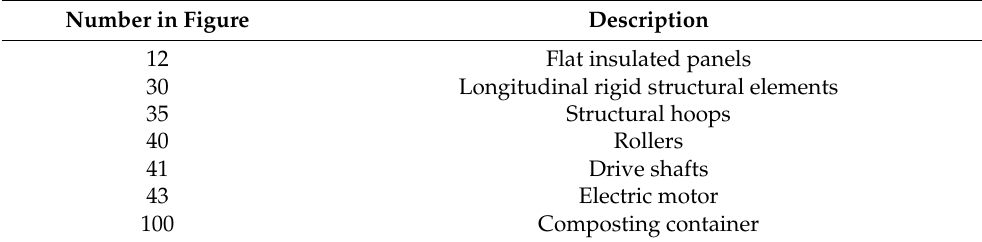
Table A4. An aerobic partially automated composter from CA2436322C [88].